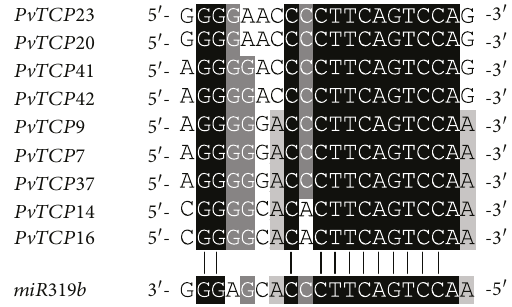
Figure 5: Putative microRNA319 -targeted binding sites of the PvTCP genes. Alignment of complementary pairing bases was generated by GenDoc. Targeted sites were retrieved from the coding sequences of PvTCP genes, while mature sequence of miR319 was rice miR319b from miRBase